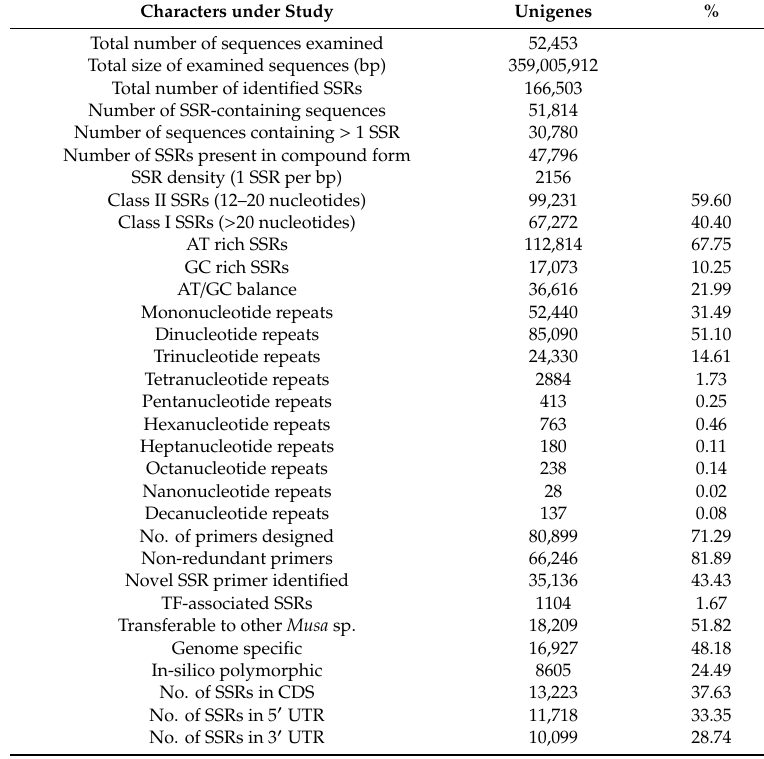
Table 1. Distribution of microsatellites in transcript sequences and functionally relevant SSR marker